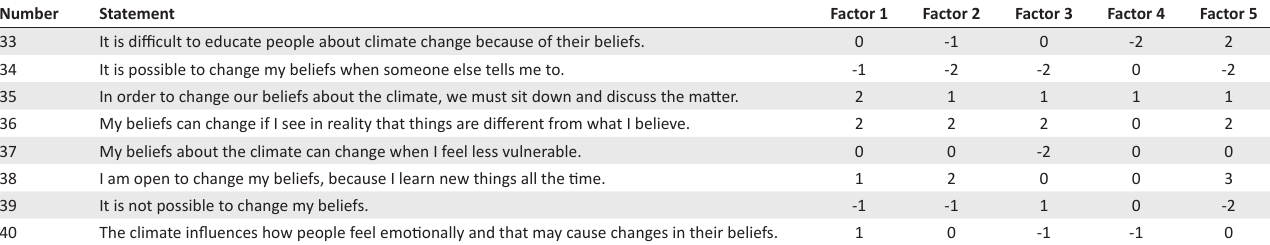
TABLE 1: Q-sort values for statements about belief